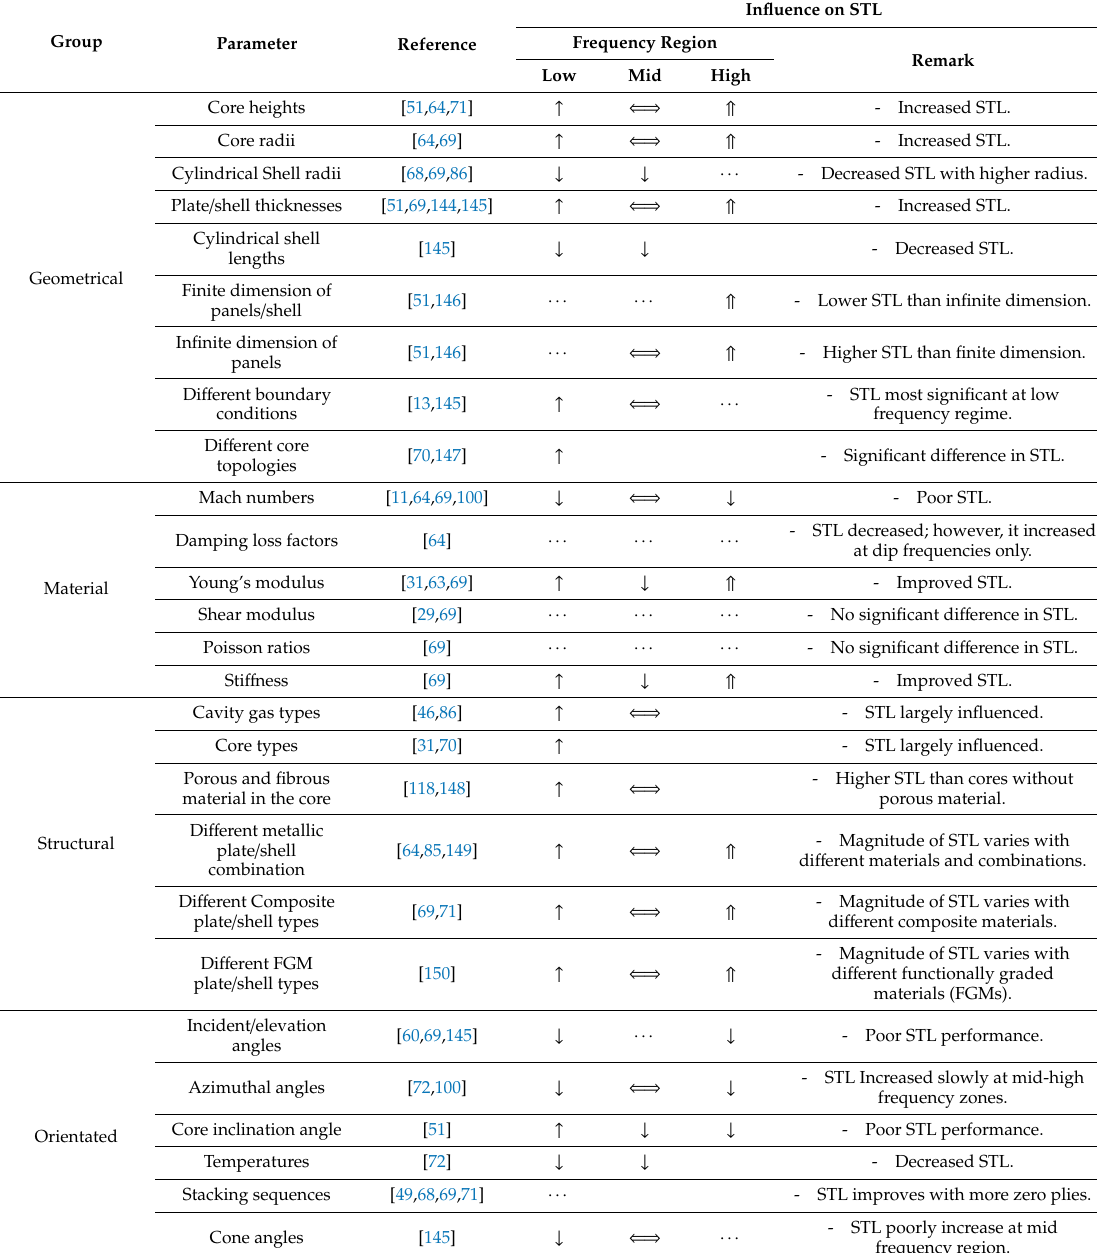
Table 2. Summary of selected studies of parameter e ff ects on STL of sandwich and composite double panel